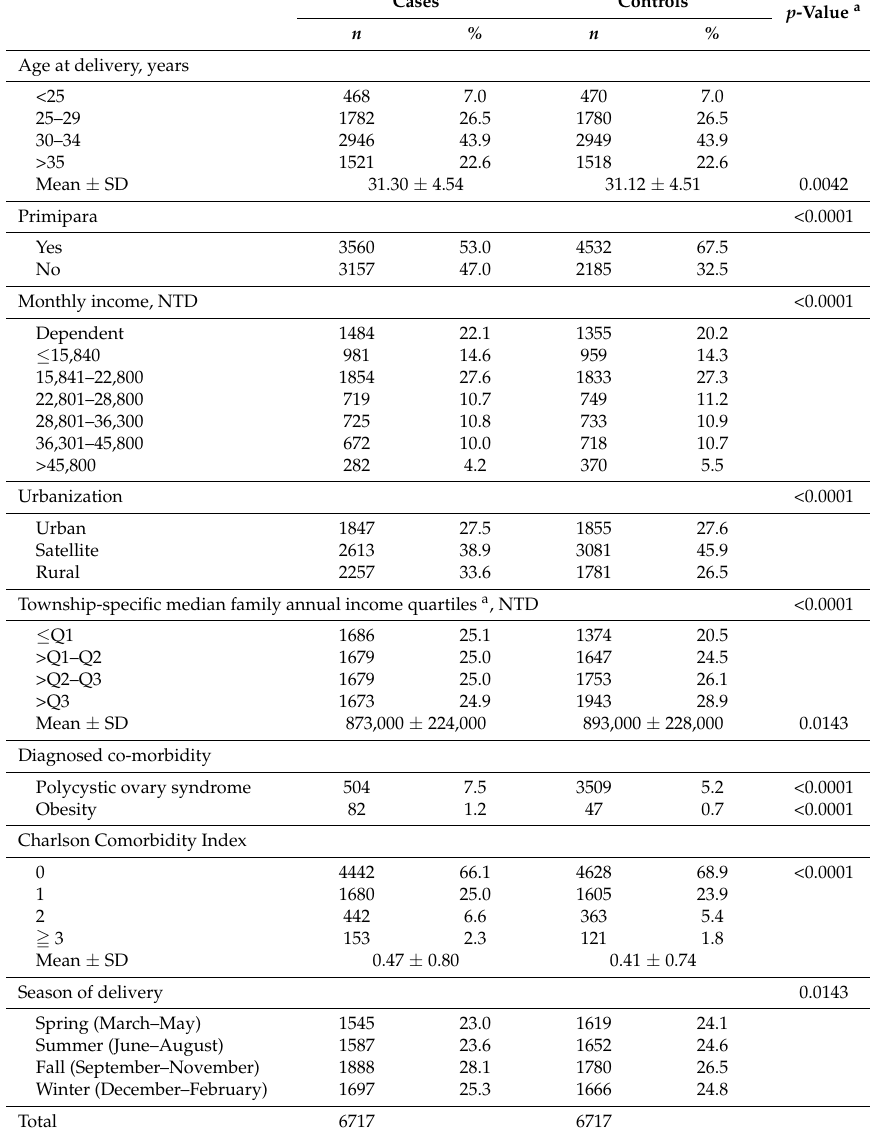
Table 1. Characteristics of cases and